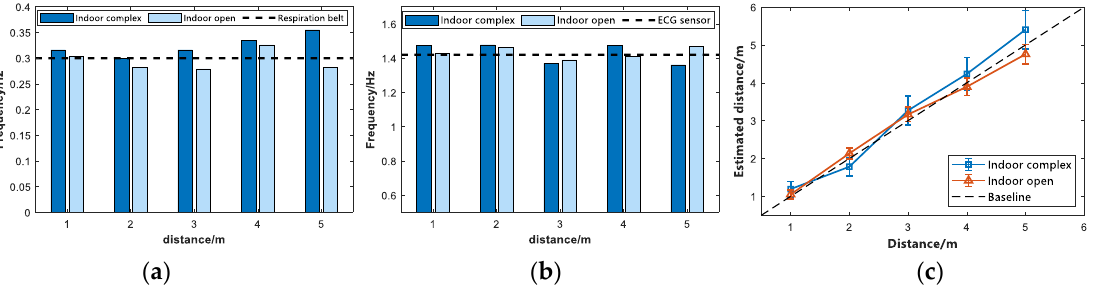
Figure 5. Vital signs signals obtained by IR − UWB radar in Outdoor open environment. ( a ) Time domain at different distances. ( b ) Frequency domain at different distances.